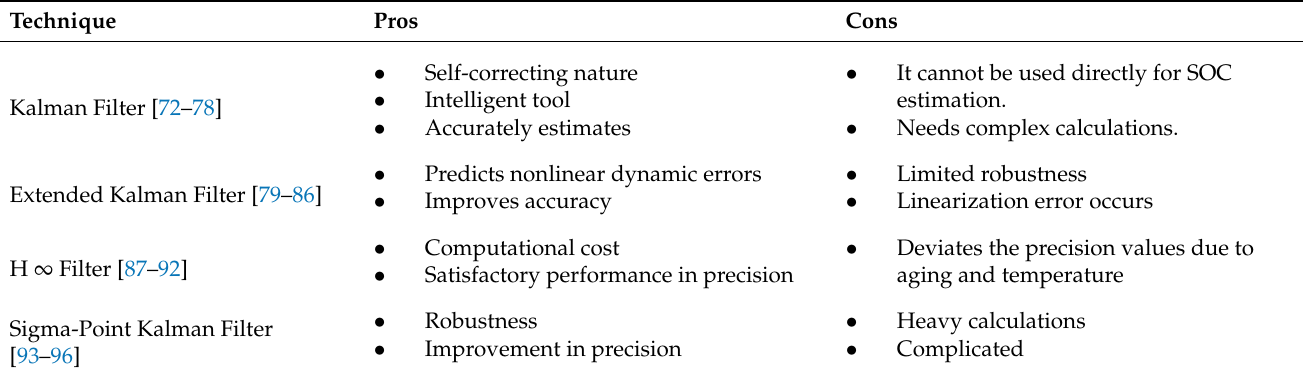
Figure 9. The comprehensive structure of neural network for SOC estimation [97]. Table 6. Analysis of the different adaptive filter SOC estimation